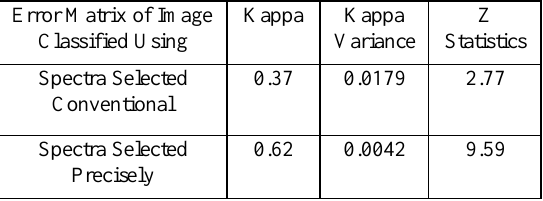
Table 12: Individual Error Matrix Kappa Analysis Results Error Matrix of Image